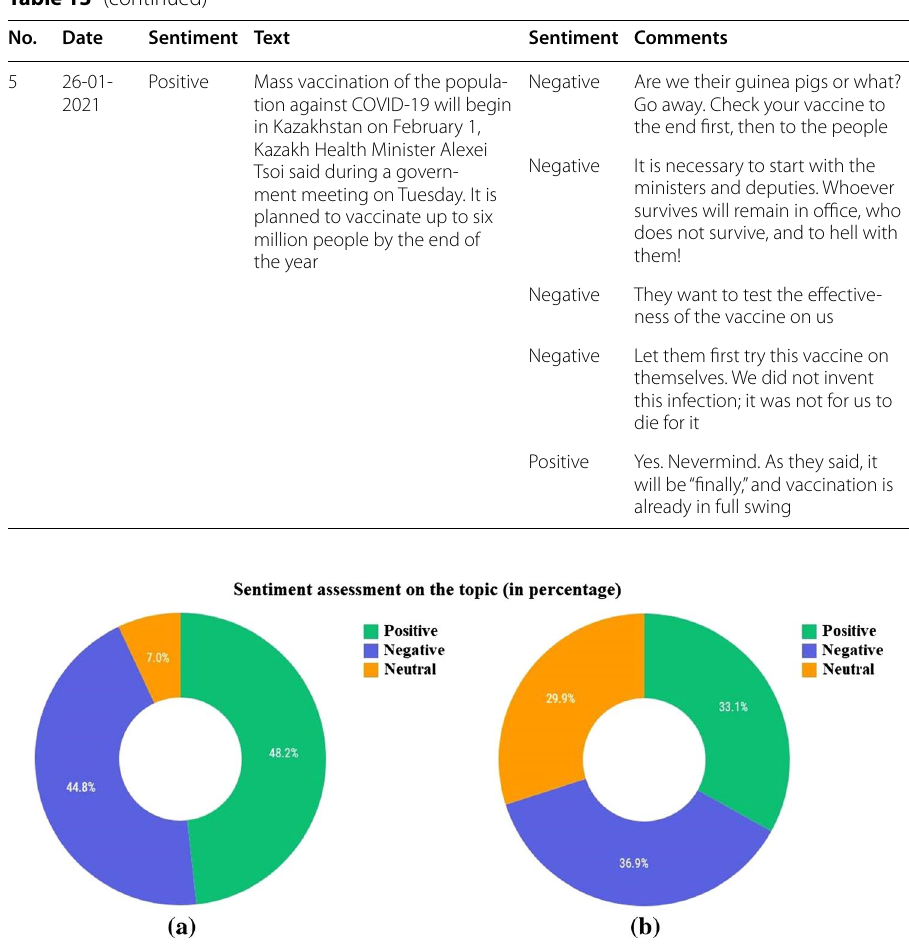
Fig. 25 Evaluation of the sentiment of the second period— a Almaty and Nur-Sultan, b large regional